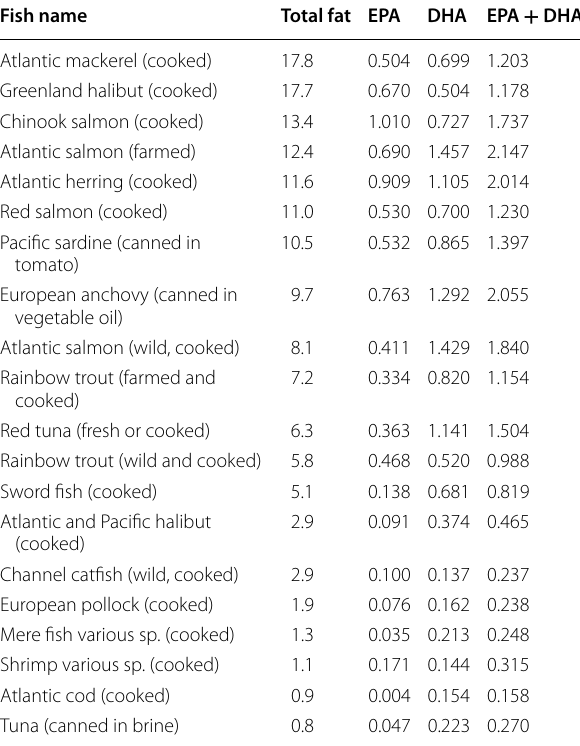
Table 1 Amounts of total fat, EPA, DHA and EPA (g/100 g of serving) in fish species of different origin and